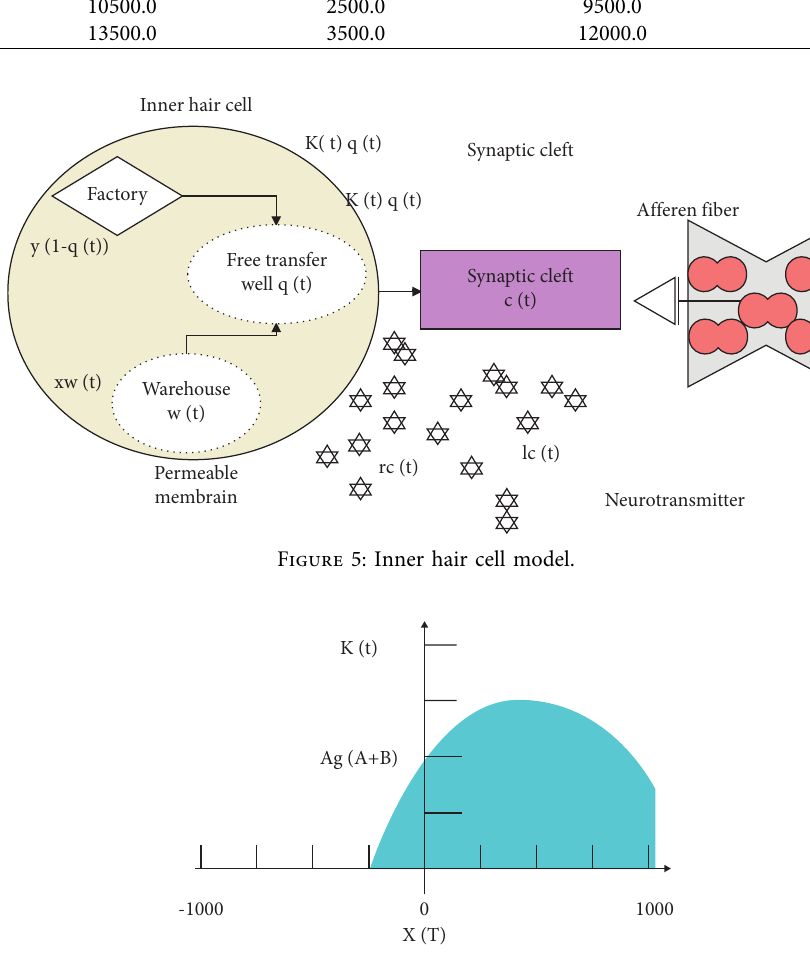
Figure 6: Cell membrane permeability change curve with instantaneous acoustic wave